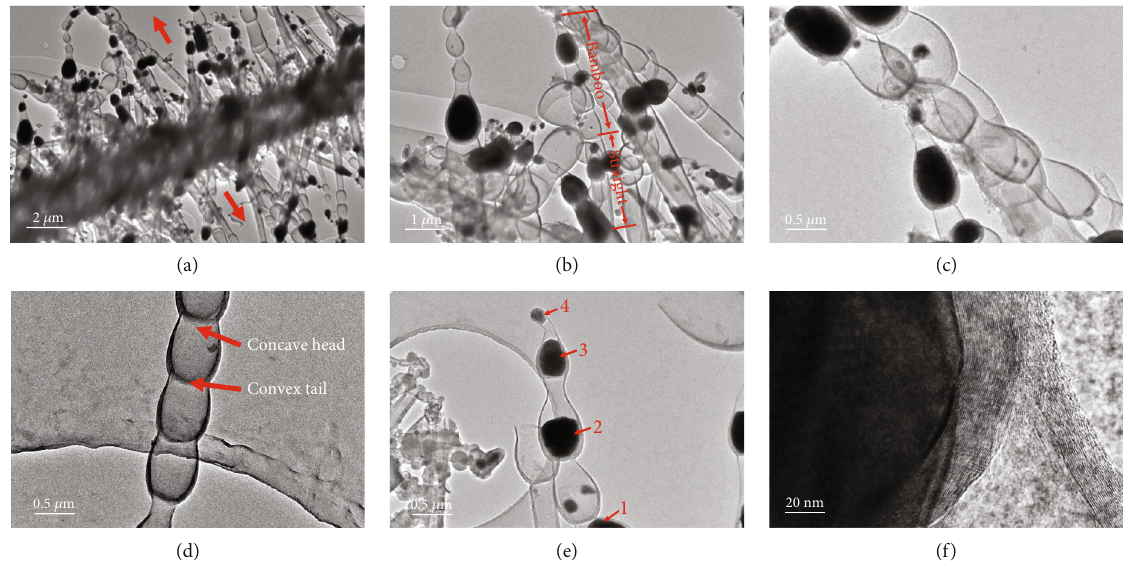
Figure 4: (a, b) TEM images of the bamboo-shaped CNTs synthesized by 60 s microwave time. The bamboo-shaped CNTs are found to grow in opposite directions from the sheet-like substrate in (a), and the growth direction is marked with red arrows. The bamboo-shaped CNTs are found to compose of one straight part with smooth and continuous tube wall and the other part with bamboo-like segmented tube walls, as shown in (b). (c, d) TEM images showing the magni fi ed view of the bamboo-shaped CNTs. The catalyst Fe NPs can be observed at the tips of the CNTs, as shown in (c). And the growth direction of the bamboo-shaped CNTs is identi fi ed to be from the convex tails to the concave heads, as shown in (d). (e) Liquifying cascade growth mode similar to the 30s situation is also observed for the 60 s CNTs. The cascading catalyst NPs with reducing sizes are numbered with arithmetic orders. (f) HRTEM image showing the well-stacking graphitized tube walls of the bamboo-shaped